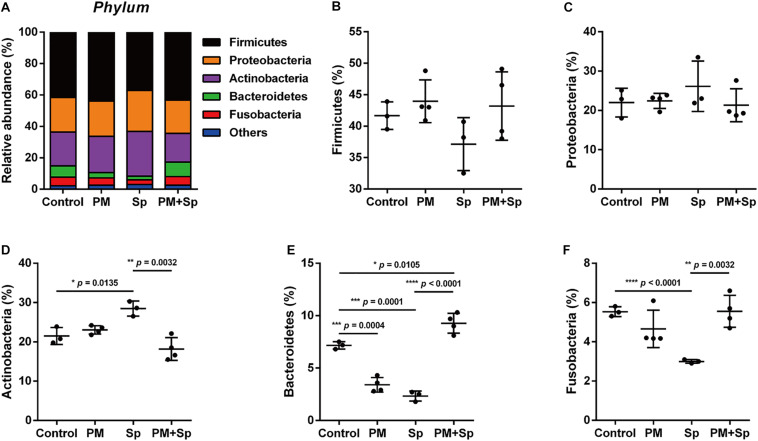
Relative abundance of bacterial phyla in mice exposed to PM2.5 and pneumococcus. The bacteria taxonomic profiles at the phylum level in BALF microbiota from PM2.5-treated (PM) and/or pneumococcus-infected (Sp) mice. (A) The top 5 most abundant phyla in the four groups were shown. Relative abundances of (B)
Firmicutes, (C)
Proteobacteria, (D)
Actinobacteria, (E)
Bacteroidetes, and (F)
Fusobacteria in the BALF microbiota community were analyzed. Student’s t-test was used to analyze the statistical significance of the experimental results between two groups. *P < 0.05; **P < 0.01; ***P < 0.001.